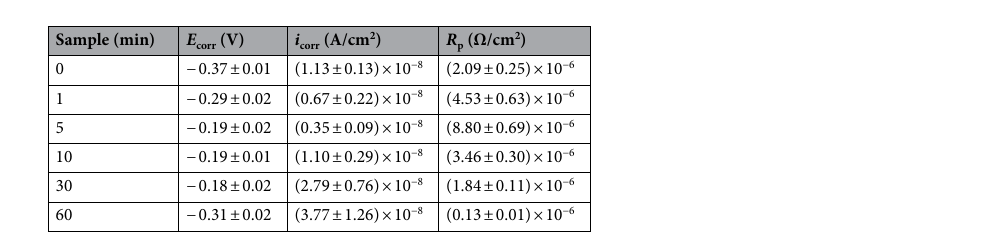
Table 2. The average E corr , i corr , and R p values of the untreated and heat-treated TiZr alloy specimens.